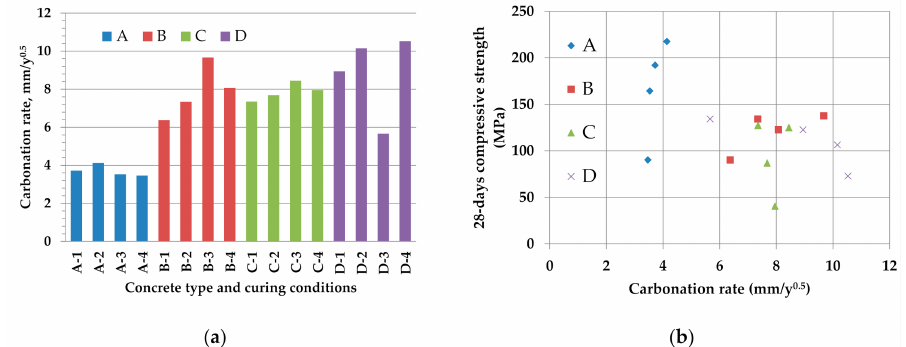
Figure 4. Carbonation rate of four high strength concretes cured at four different conditions: ( a ) car- bonation rate; ( b ) Carbonation rate versus compressive strength relationship.